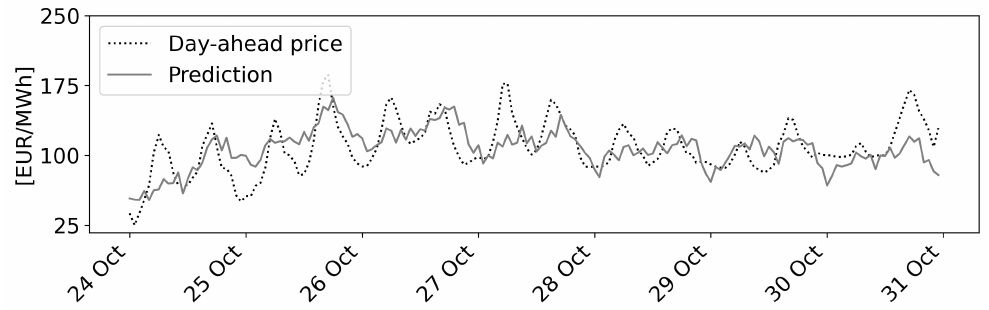
Figure 12. LSTM prediction for test scenario